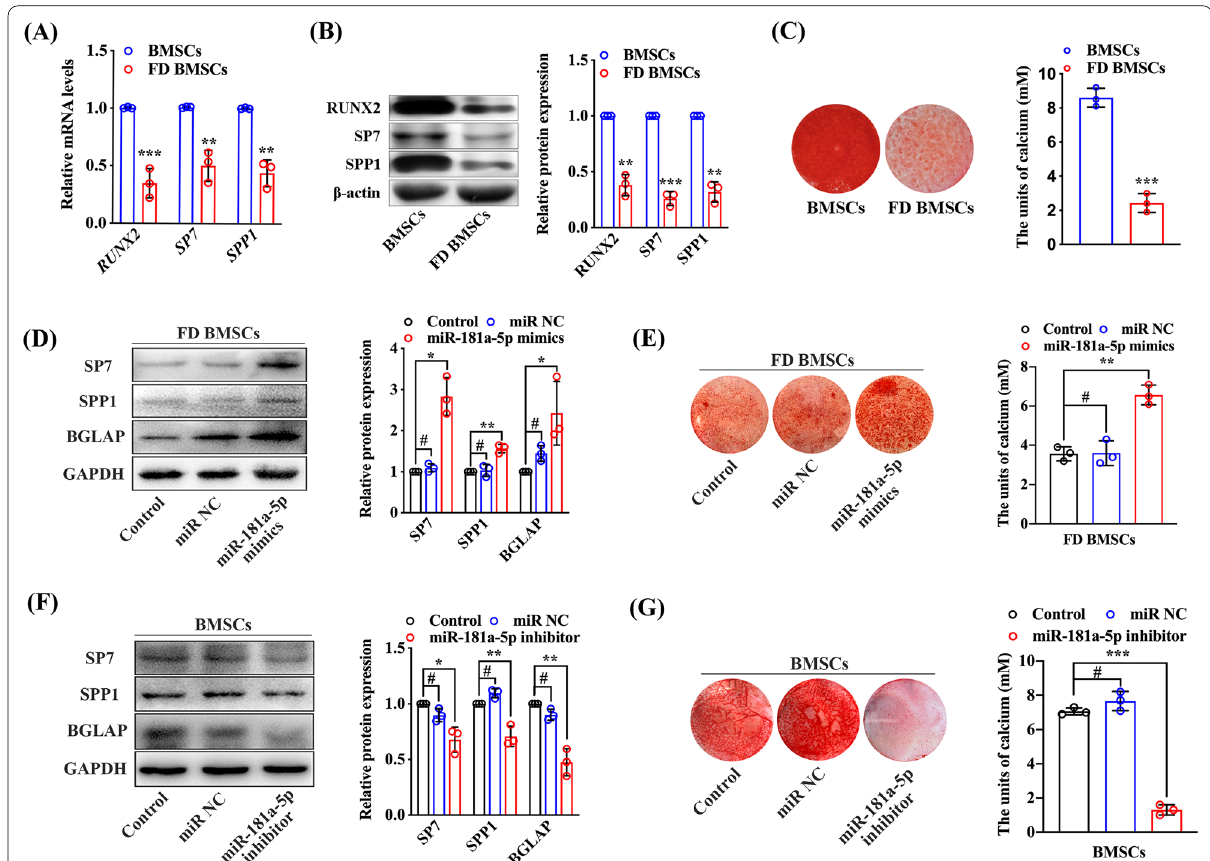
Fig. 3 Low miR-181a-5p expression promotes osteogenic properties in FD BMSCs. a Quantitative real-time PCR analysis of osteogenesis-related marker mRNA expression in BMSCs and FD BMSCs after osteogenic induction for 7 days. b Western blot analysis of osteogenesis-related marker protein expression in BMSCs and FD BMSCs cultured with osteogenesis induction medium for 7 days. c Alizarin red staining and CPC assay showed calcium deposition in BMSCs and FD BMSCs after 14 days of osteogenic induction. Quantitative real-time PCR ( d ) and western blot ( e ) analysis of osteogenesis-related gene and protein expression in FD BMSCs transfected with miR-181a-5p mimics. Quantitative real-time PCR ( f ) and western blot ( g ) analysis of osteogenesis-related gene and protein expression in BMSCs transfected with the miR-181a-5p inhibitor. The data are presented as the mean S.E.M. values (n 3). # P > 0.05; * P < 0.05; ** P < 0.01; *** P < ± =